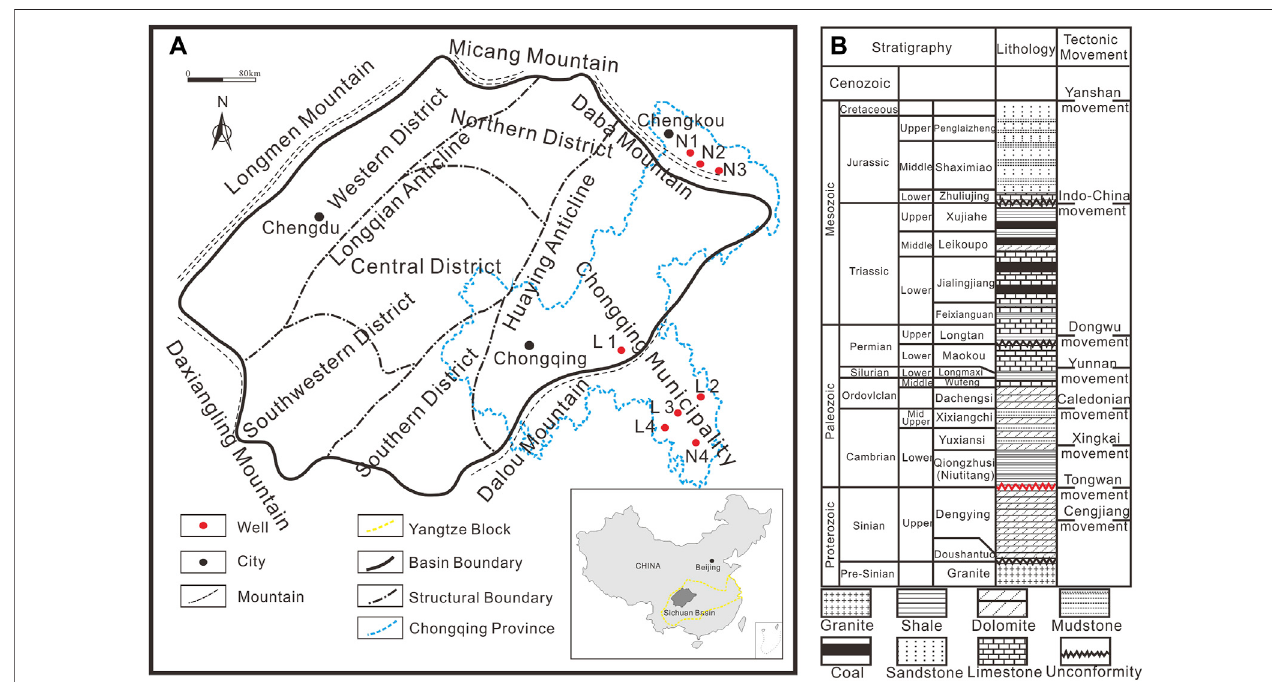
FIGURE1|(A) Geologicmapoftheresearchareaandwelllocations(redpoints)oftheLowerCambrianshale(N1,N2,N3,N4)andtheLowerSilurianshale(L1,L2, L3, L4) and (B) stratigraphic sequences of the Sichuan Basin.